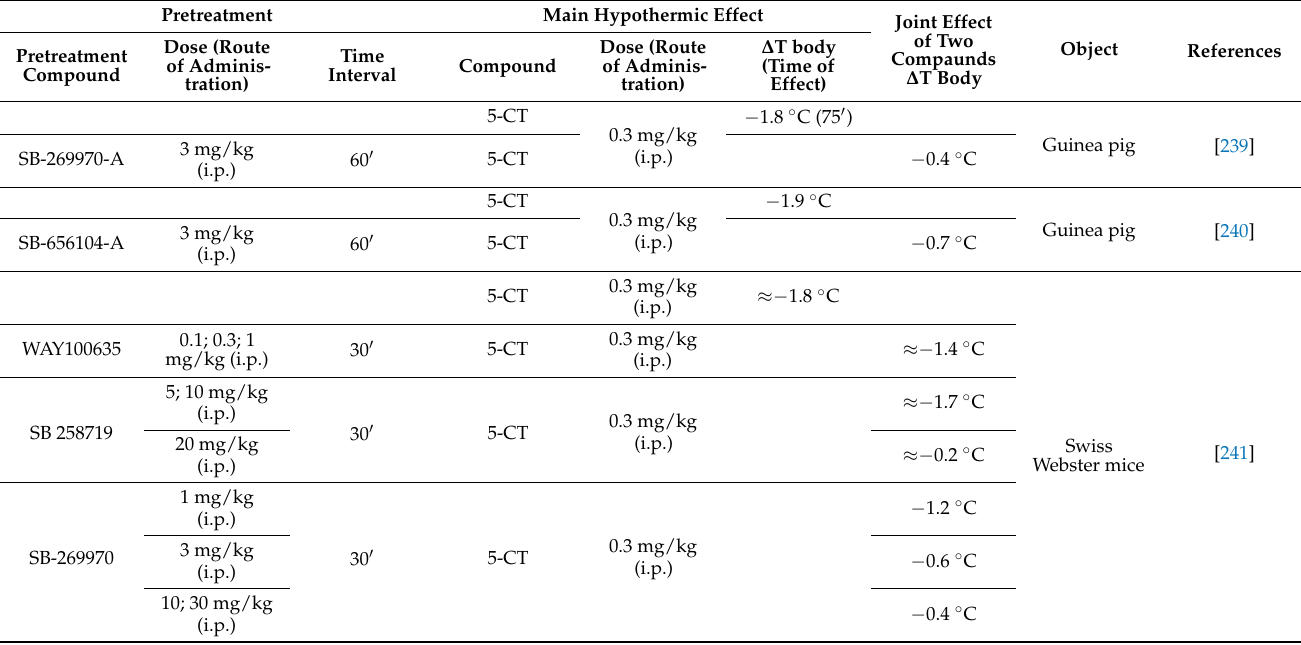
Table 9. Impact of pretreatment with 5-HT 7 and 5-HT 1A antagonists on hypothermic effects of 5-CT and 8-OH-DPAT in warm-blooded